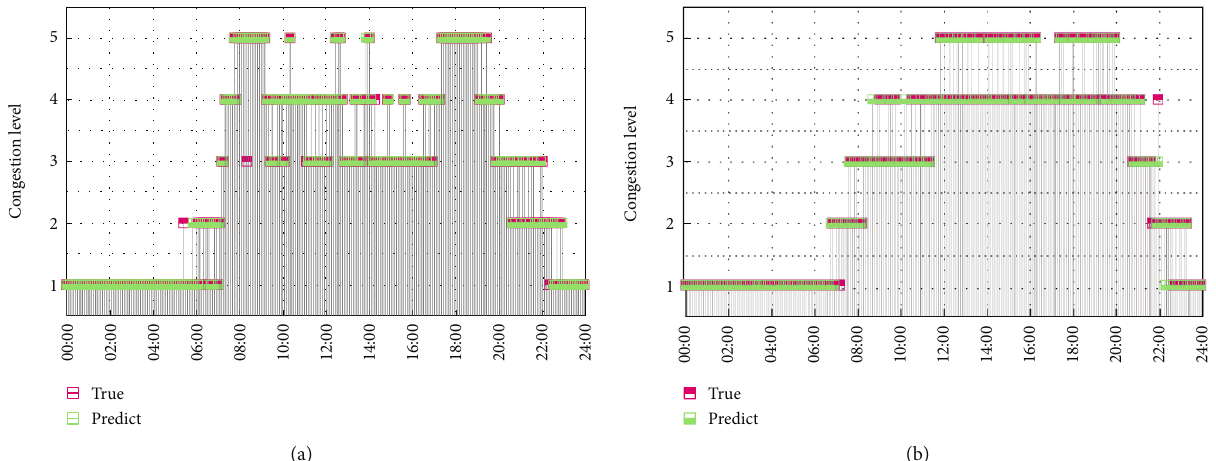
Figure 15: Comparison of actual and predicted tra ffi c conditions on weekdays and holidays.